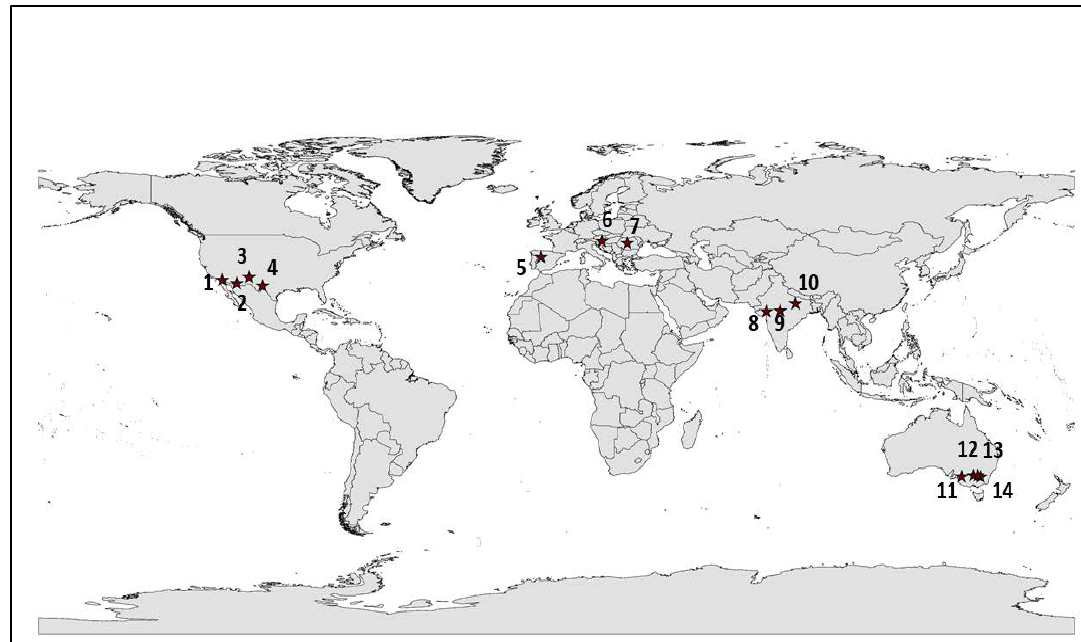
Figure 1. Locations of the validation sites used in this study; 1. Fallbrook, California, USA, 2. Tucson,